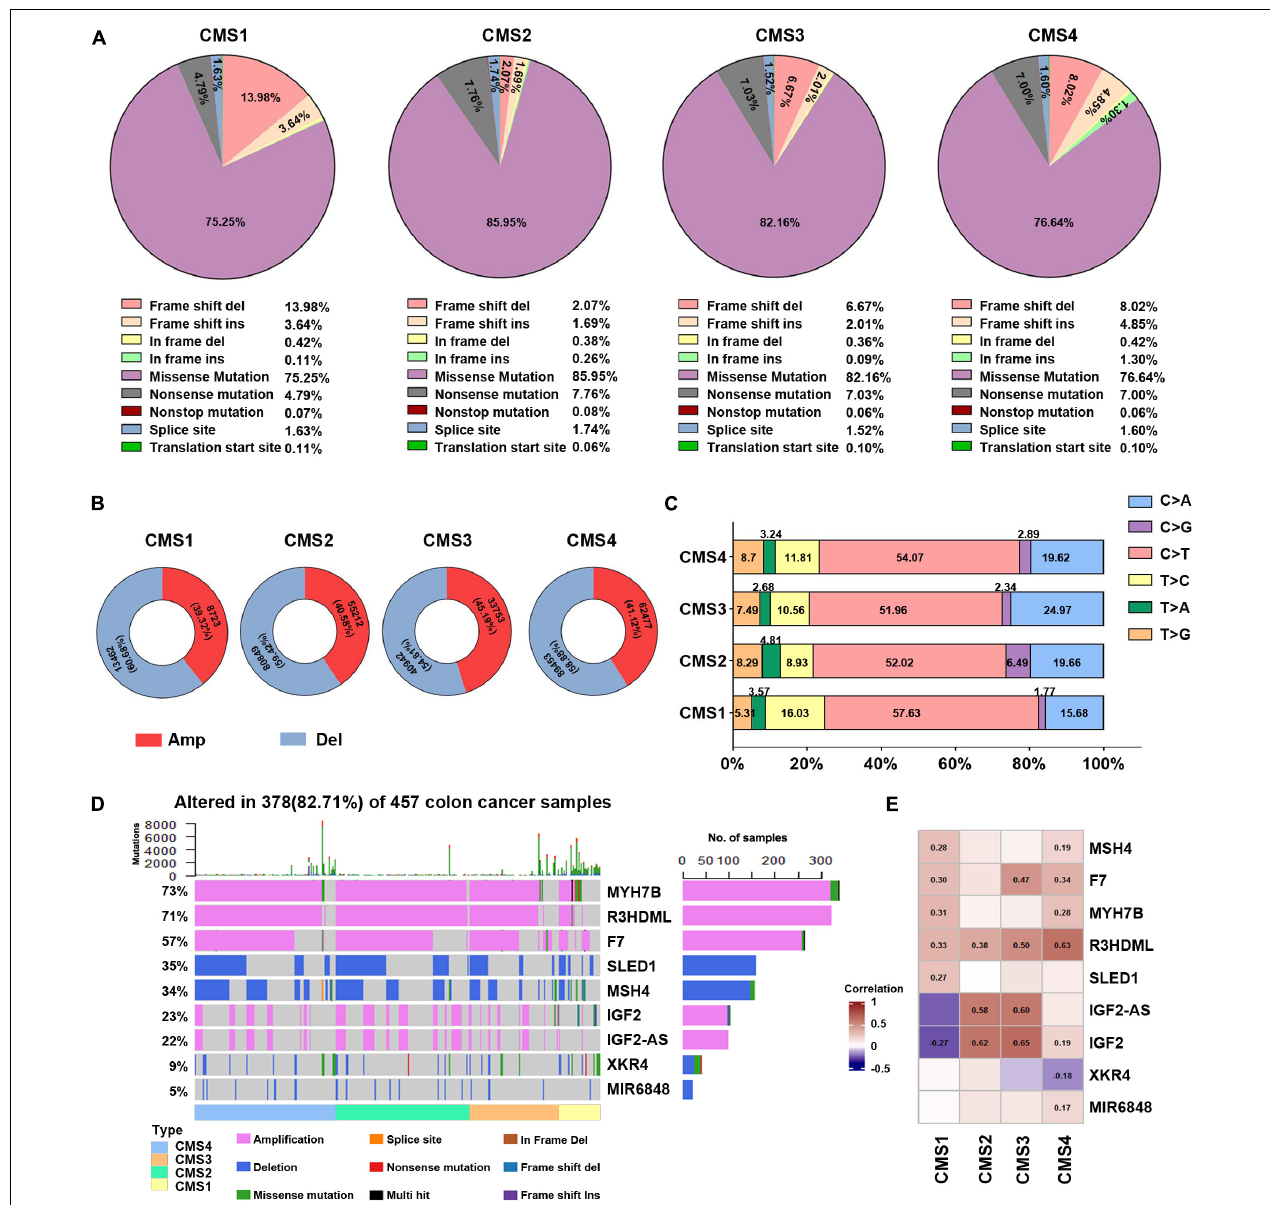
FIGURE 2 | Analysis of DNA alterations in the four colon cancer subtypes. (A) Different classified categories of DNA mutations in each colon cancer subtype. (B) Number of copy number variations (CNVs) in each subtype. Red represents amplification, and blue indicates deletion. (C) Change in the SNV transversion ratios in the different subtypes. (D) Waterfall chart of the mutations in different subtype-specific genes. (E) Correlation analysis of subtype-specific RNAs and their modifications in the different subtypes. The numbers in the figure are correlation coefficients, where a negative value represents a negative correlation and a positive value represents a positive